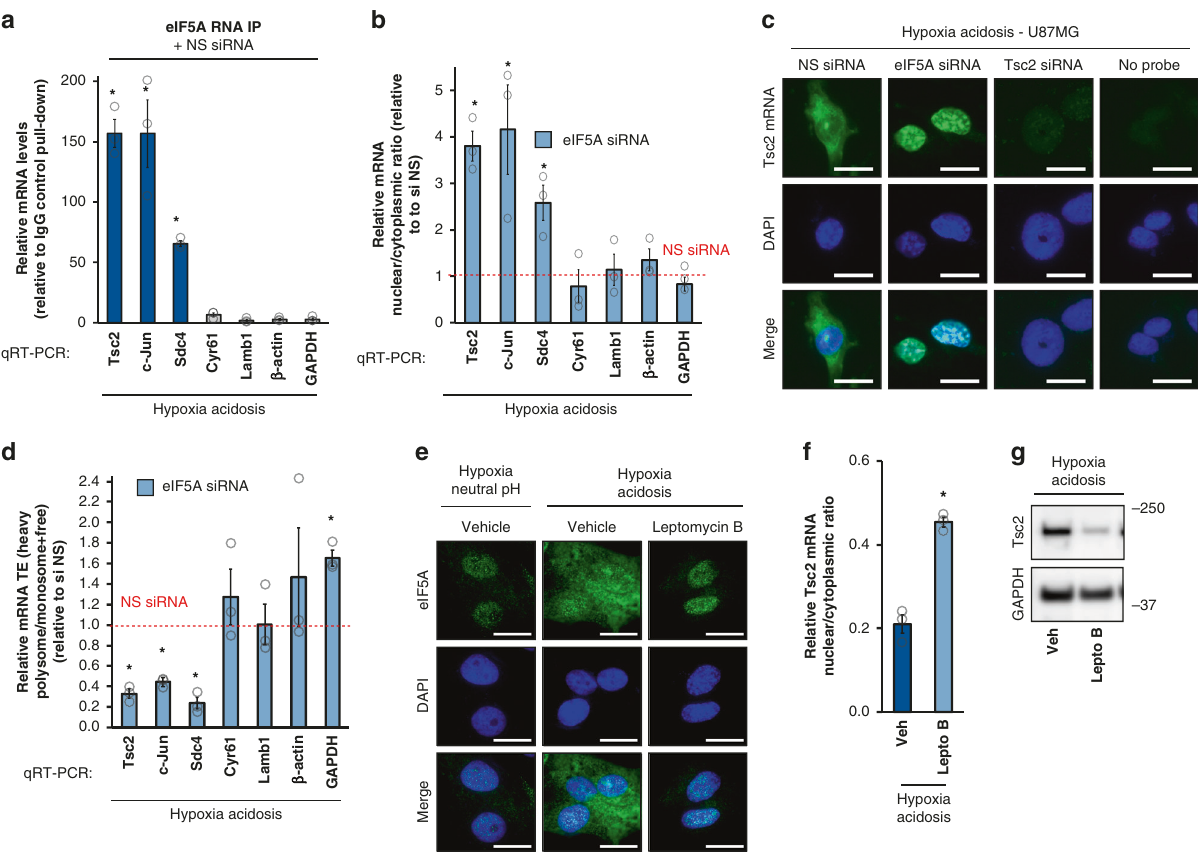
Fig. 6 Mechanism of eIF5A-mediated Tsc2 protein induction. a Co-immunoprecipitated mRNA levels of eIF5A-regulated and nonregulated mRNAs relative to IgG isotype control pulldown. Data represent mean ± SEM ( n = 3). An asterisk indicates p = 0.005, 0.031, and 0.001 (Tsc2, c-Jun, and Sdc4) compared to IgG control, two-sided student ’ s t test. b Effect of eIF5A knockdown on mRNA subcellular localization of indicated mRNAs under hypoxia acidosis conditions. NS nonsilencing. Data represent mean ± SEM ( n = 3). An asterisk indicates p = 0.007, 0.041, and 0.027 (Tsc2, c-Jun, and Sdc4) eIF5A siRNA compared to NS siRNA, two-sided student ’ s t test. c mRNA fl uorescent in situ hybridization. NS nonsilencing. One-third exposure level was used for Tsc2 mRNA FISH under eIF5A siRNA conditions relative to all other conditions to avoid signal saturation ( n = 5). Scale bars: 20 μ m. d Effect of eIF5A knockdown on translation ef fi ciencies of indicated mRNAs under hypoxia-acidosis conditions. NS nonsilencing. Data represent mean ± SEM ( n = 3). An asterisk indicates p = 0.0.004, 0.002, and 0.006 (Tsc2, c-Jun, and Sdc4) eIF5A siRNA compared to NS siRNA, two-sided student ’ s t test. e Effect of leptomycin B treatment on eIF5A protein subcellular localization in U87MG under indicated conditions. Vehicle: DMSO ( n = 5). Scale bars: 20 μ m. f Effect of leptomycin B treatment on Tsc2 mRNA subcellular localization under hypoxia-acidosis conditions. Vehicle (Veh): DMSO. Data represent mean ± SEM ( n = 5). An asterisk indicates p = 0.015 compared to DMSO vehicle, two-sided student ’ s t test. g Representative immunoblot of Tsc2 protein levels in U87MG treated with leptomycin B ( n =